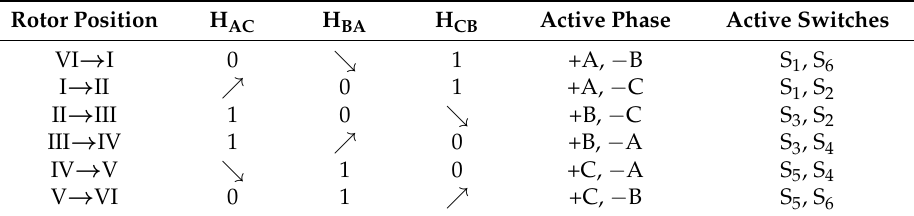
Figure 6. Digital position signals in the 60 ◦ - α mode. Table 2. Commutation control strategy in the 60 ◦ - α compensation mode.